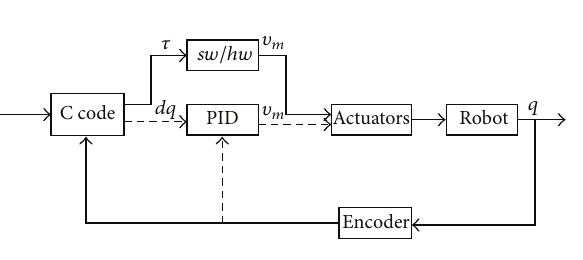
Figure 14: Classical force controller with internal position closed- loop [1].